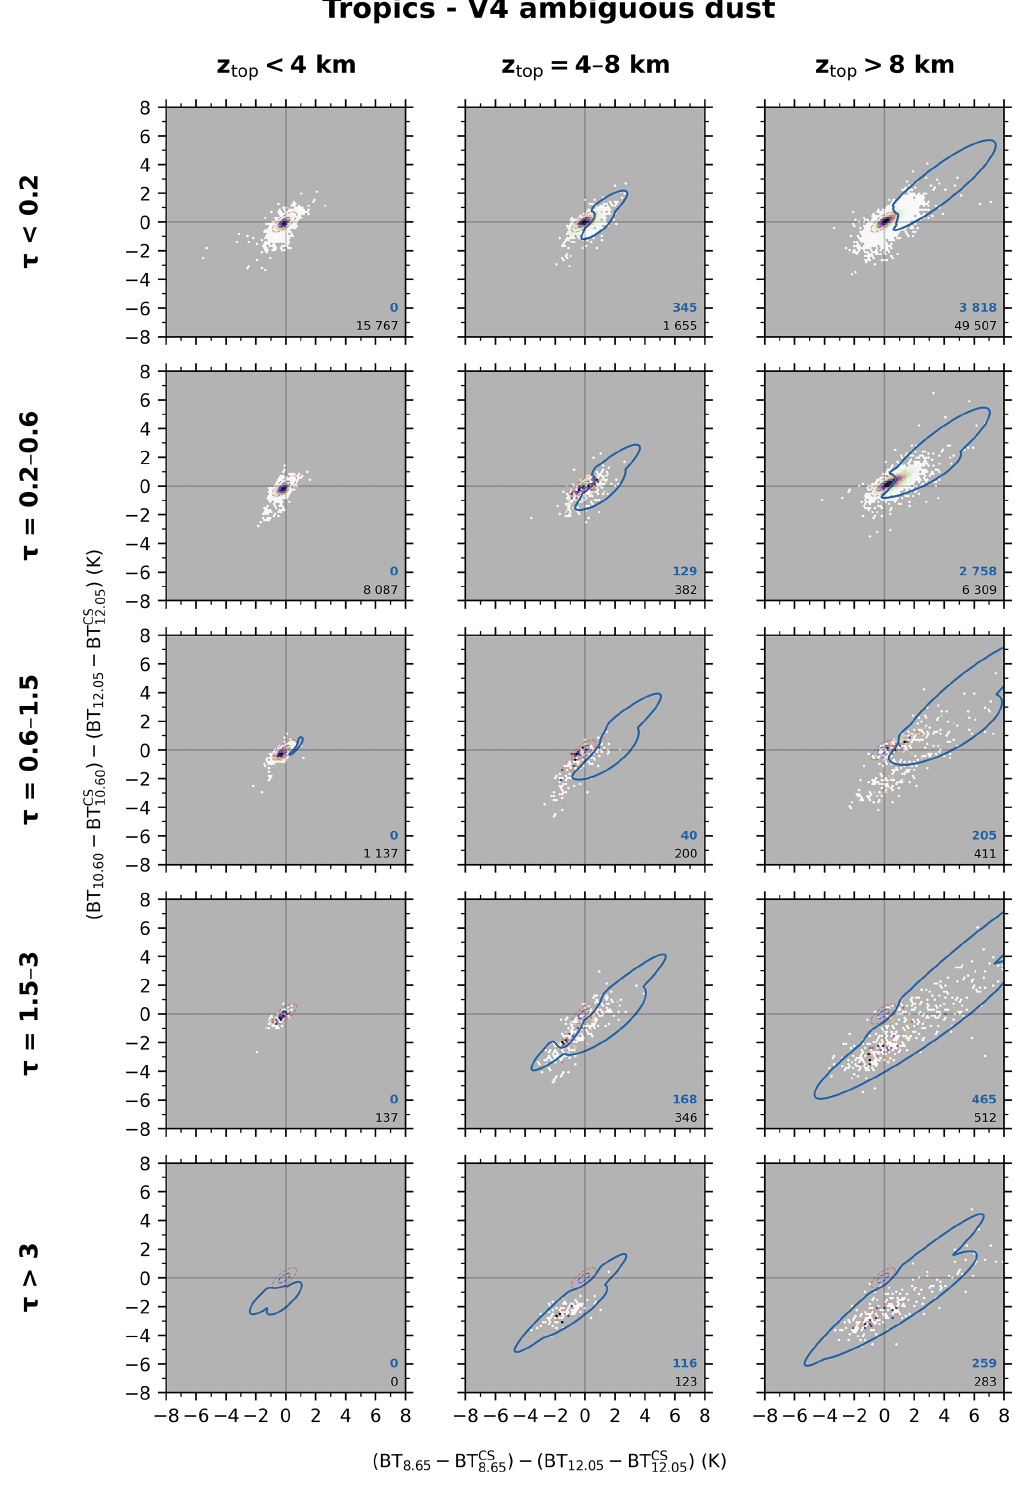
Figure 16. As Fig. 15 for dust monolayer observations declared as ambiguous by the V4